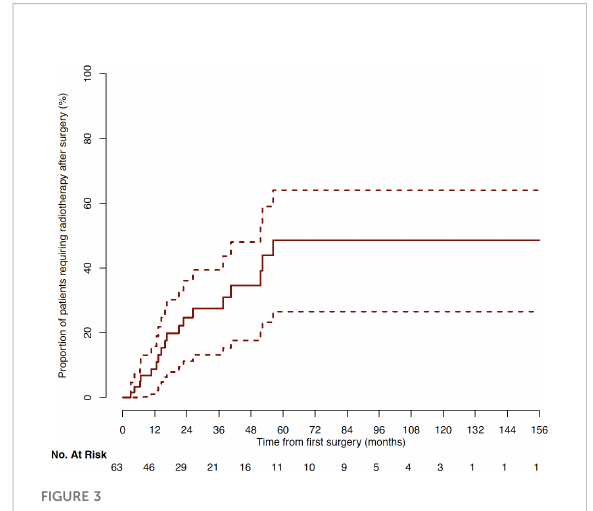
FIGURE 3 Cumulative incidence of patients requiring radiotherapy after surgery (Kaplan-Meyer